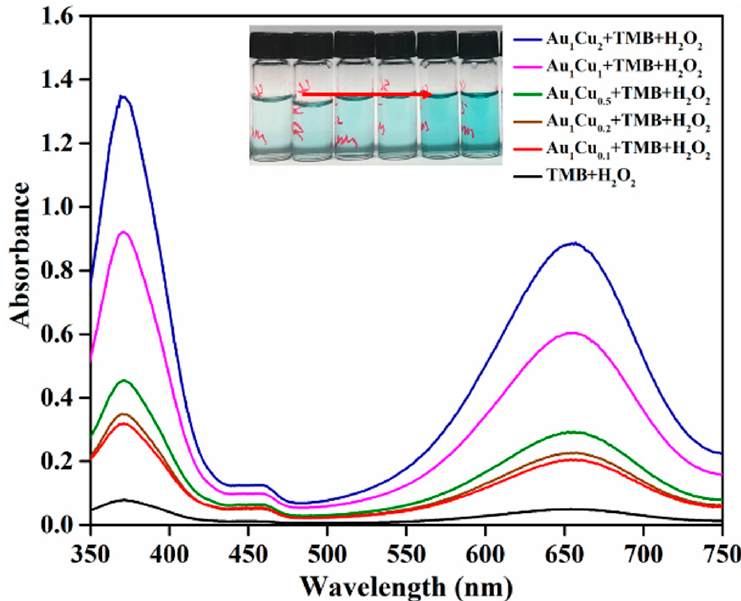
Figure 4. Ultraviolet-visible absorption spectra of 3,3 ′ ,5,5 ′ -tetramethylbenzidine (TMB) in different reaction systems.